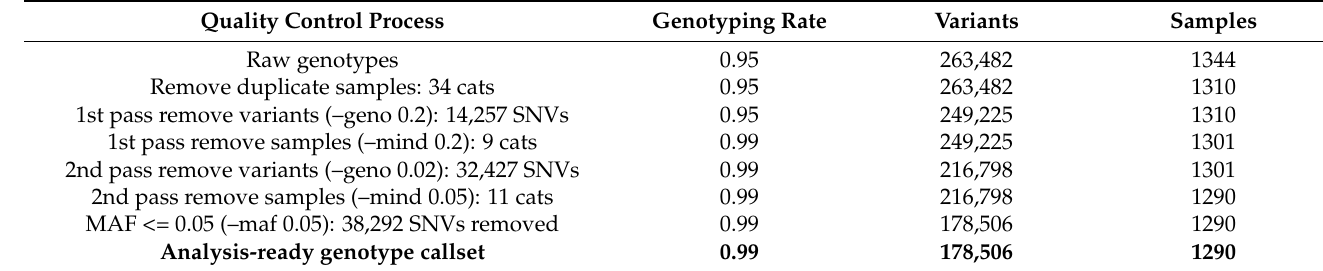
Table 1. Post-genotyping quality control. Six filtering steps were applied to remove duplicate samples as well as single nucleotide variants (SNVs) and samples with poor genotyping performance. MAF = minor allele frequency. PLINK v1.90b commands are in round brackets.